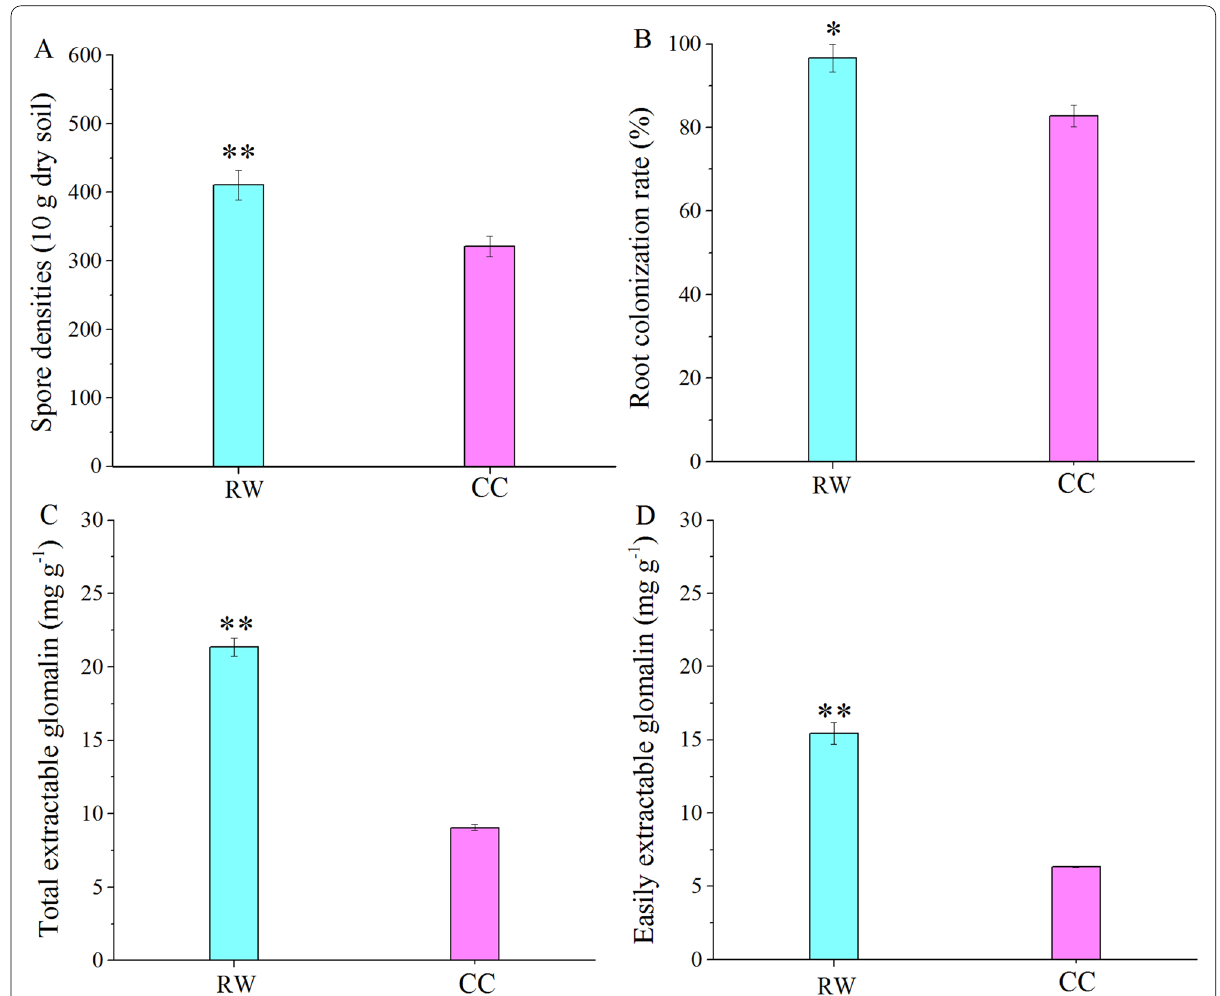
Fig. 4 Comparisons of the rhizosphere AMF and their related parameters in A. sinensis seedlings between RW and CC. Significant differences were determined using least significant differences ( LSD 0.05) of the Student’s t -test after one-way ANOVA, n 3, (* P < 0.05; ** P < 0.01). A ≤ = Spore densities in rhizosphere soil of seedlings in RW and CC. B Root colonization rate of seedlings in RW and CC. C Total extractable glomalin in rhizosphere soil of seedlings in RW and CC. D Easily extractable glomalin in rhizosphere soil of seedlings in RW and